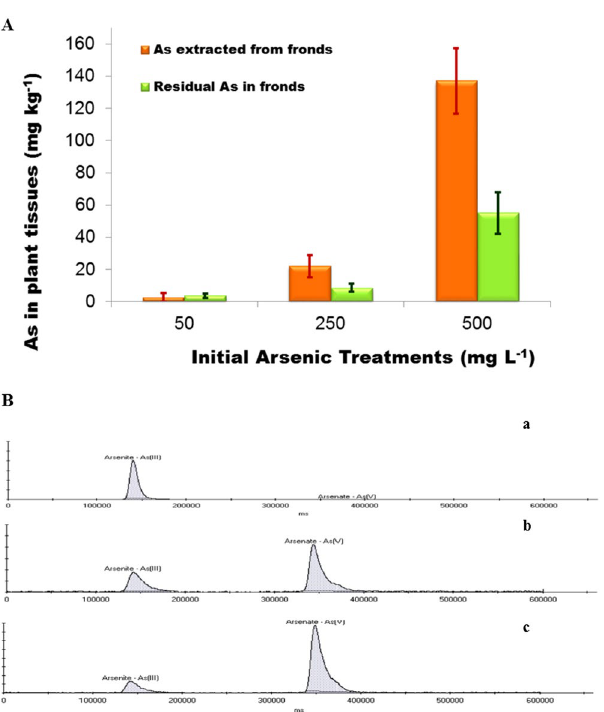
a) 0.67 mM, b) 3.3 mM, and c) 6.7 mM initial As (V) concentrations. The extracts were diluted 100; 5,000 and 10,000 fold respectively for anatytical